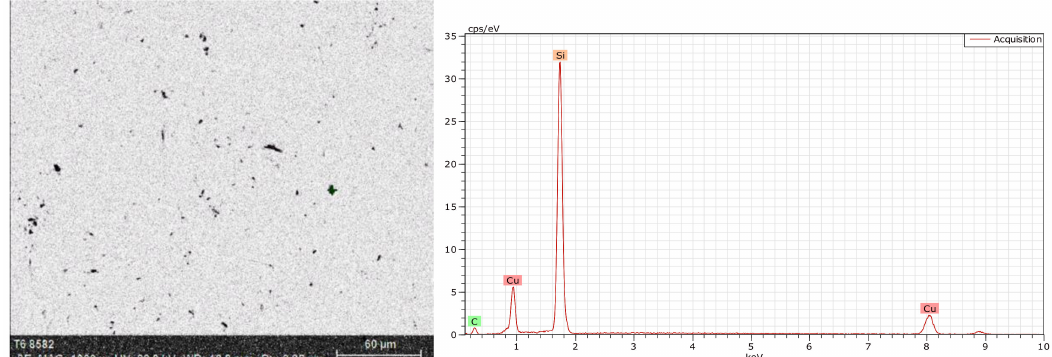
Figure 6. Energy spectrum analysis of the spot-like